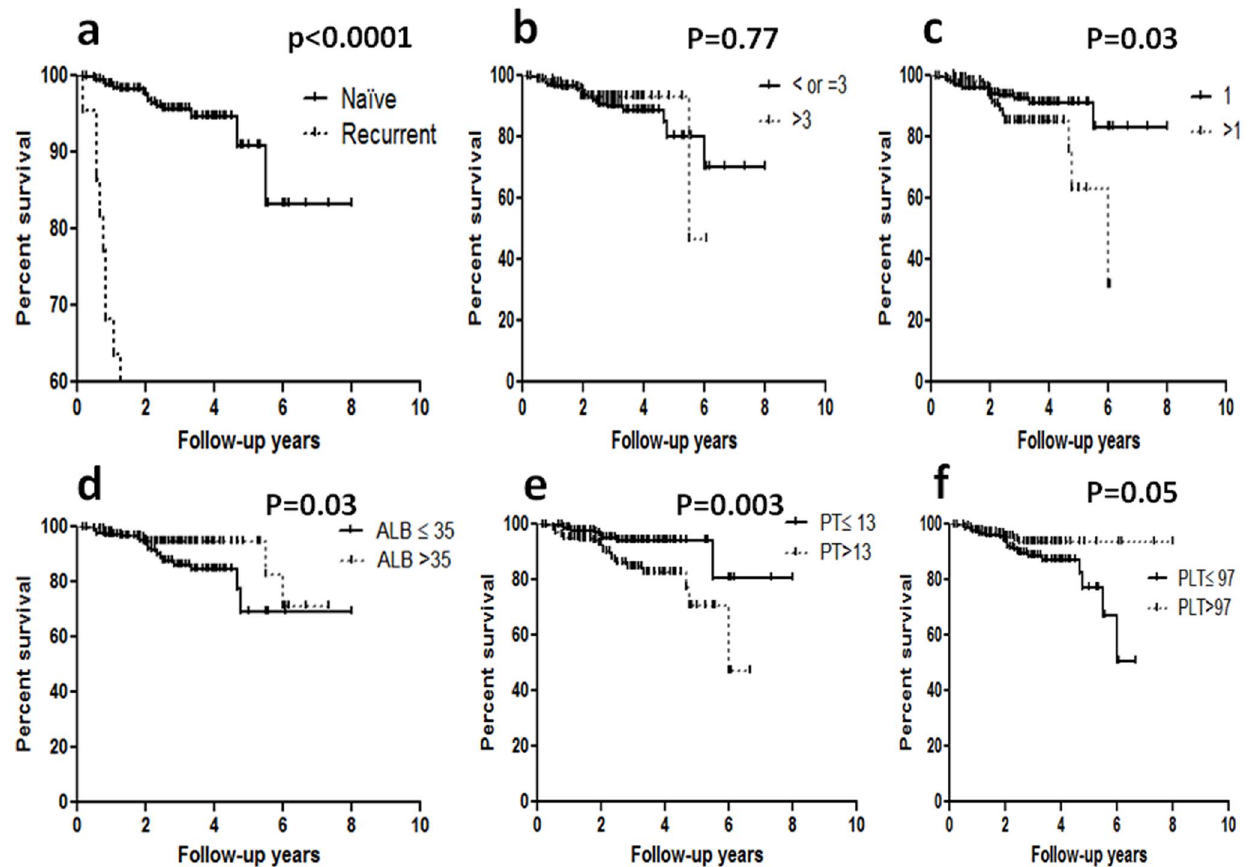
Figure 2. Cumulative overall survival in hepatocellular carcinoma (HCC) patients stratified by naı¨ve or recurrent (a), tumor diameter (cm) (b), number of tumors (c), albumin (ALB) (g/dL) (d), prothrombin time (PT) (e) or platelet count (PLT) (f). The tumor recurrent status, number of tumors, ALB, PT and PLT were significantly associated with poor overall survival after RFA combined with TACE for HCC.